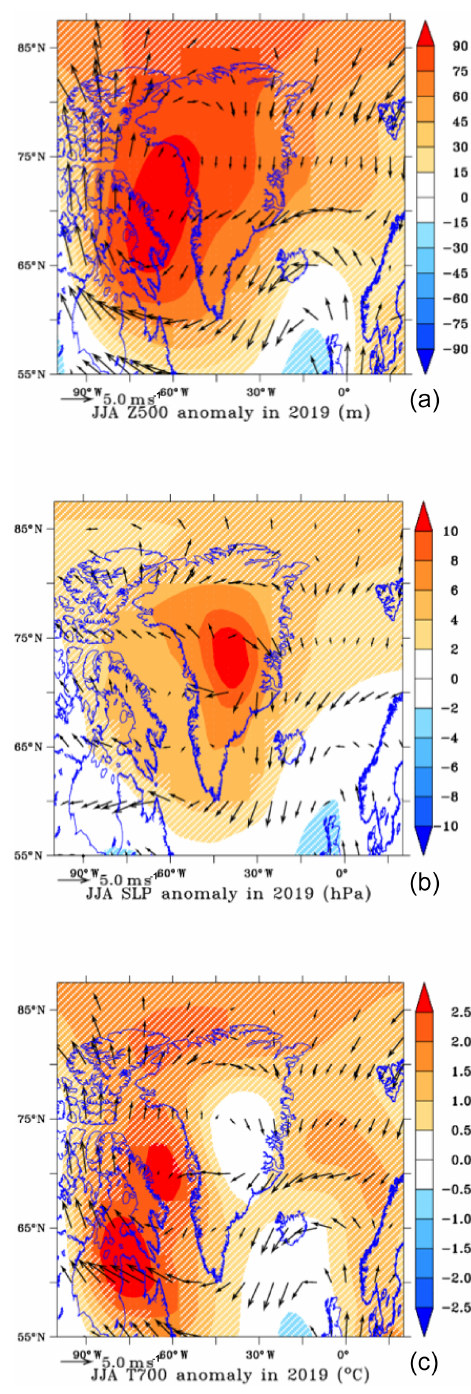
Figure 10. (a) JJA 2019 averaged geopotential height anomalies at 500hPa (Z500 in meters, baseline period 1981–2010) from the NCEP/NCARv1 reanalysis. Anomalies below 2 times the inter- annual variability (i.e., not statistically significant) are hatched. (b) Same as (a) but for the sea level pressure (hPa) and for (c) JJA temperature at 700hPa ( ◦ C). In each panel, arrows represent the anomaly of JJA winds at (a) 500hPa, (b) 10m, and (c)